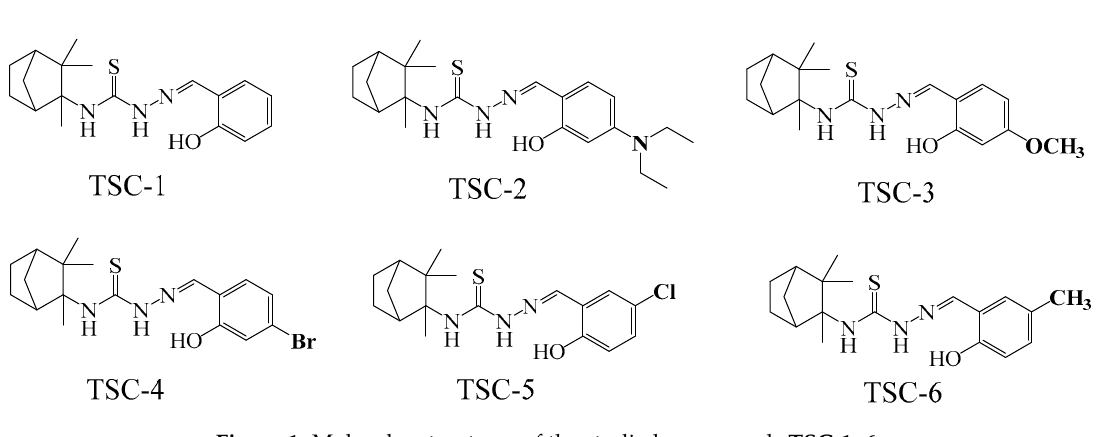
Figure 1. Molecular structures of the studied compounds TSC-1~6.